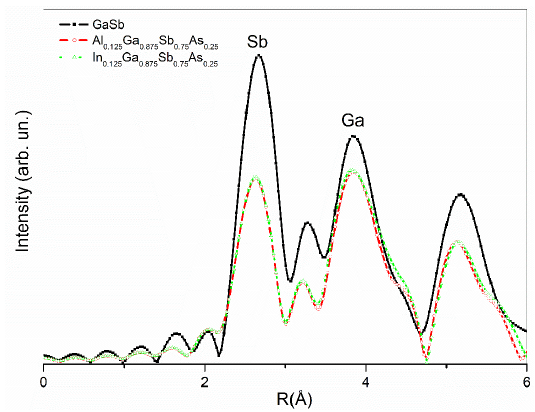
Figure 4. FT ‐ EXAFS scattering data of GaSb and (Al, In) 0.125 Ga 0.875 SbAs nanostructured